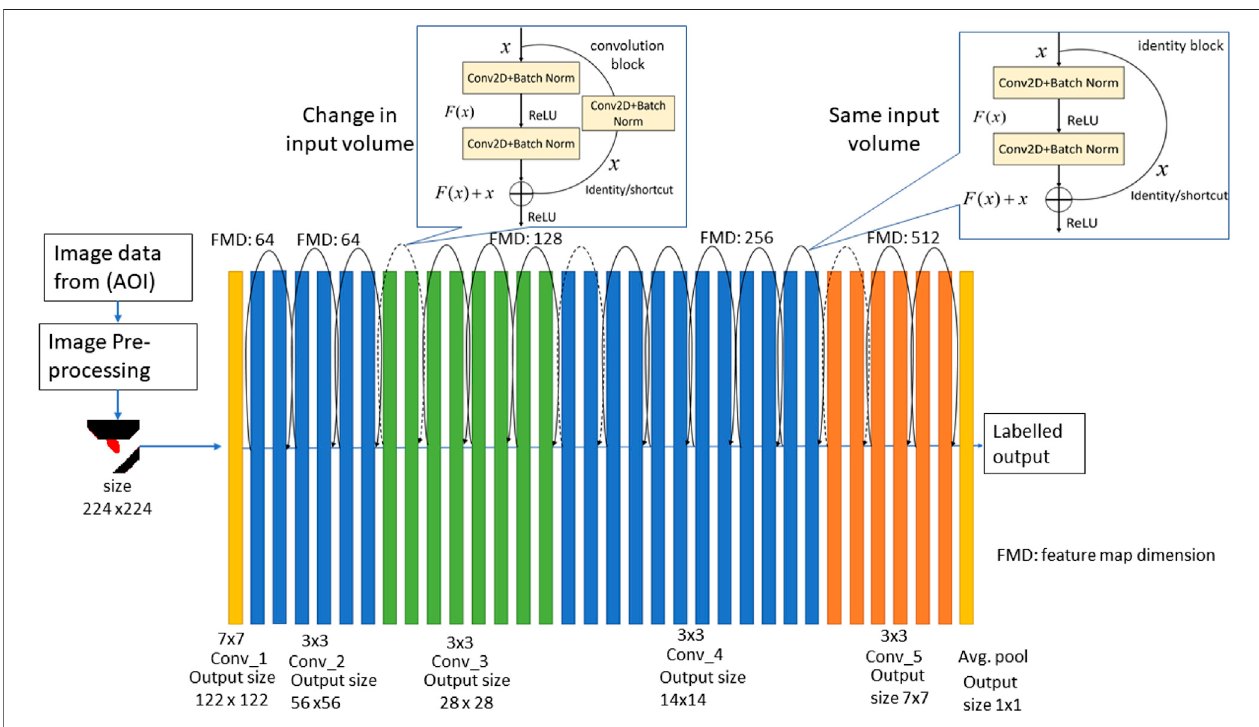
FIGURE 2 | Overview of ResNet